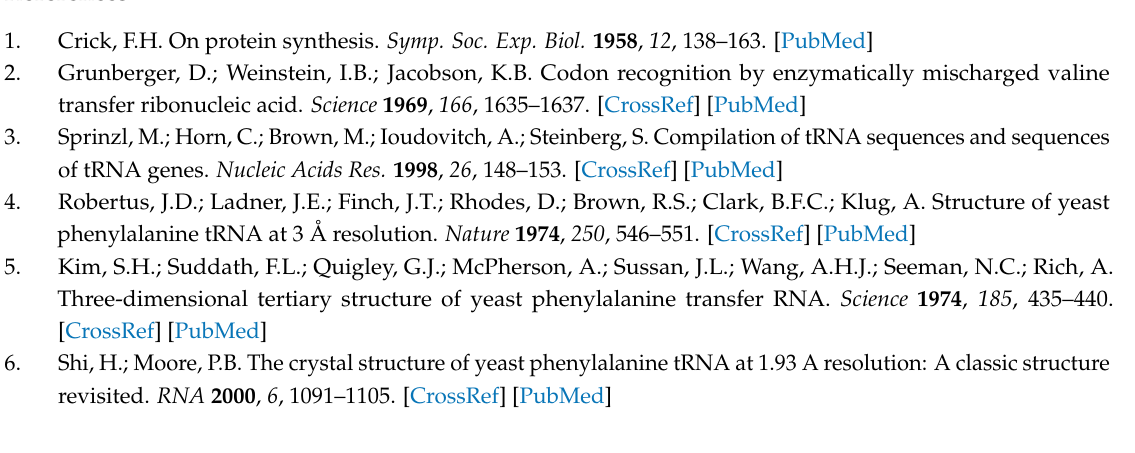
Table S1: Abbreviations of modified nucleosides, Table S2: Crystal structural studies on tRNA modification enzymes from